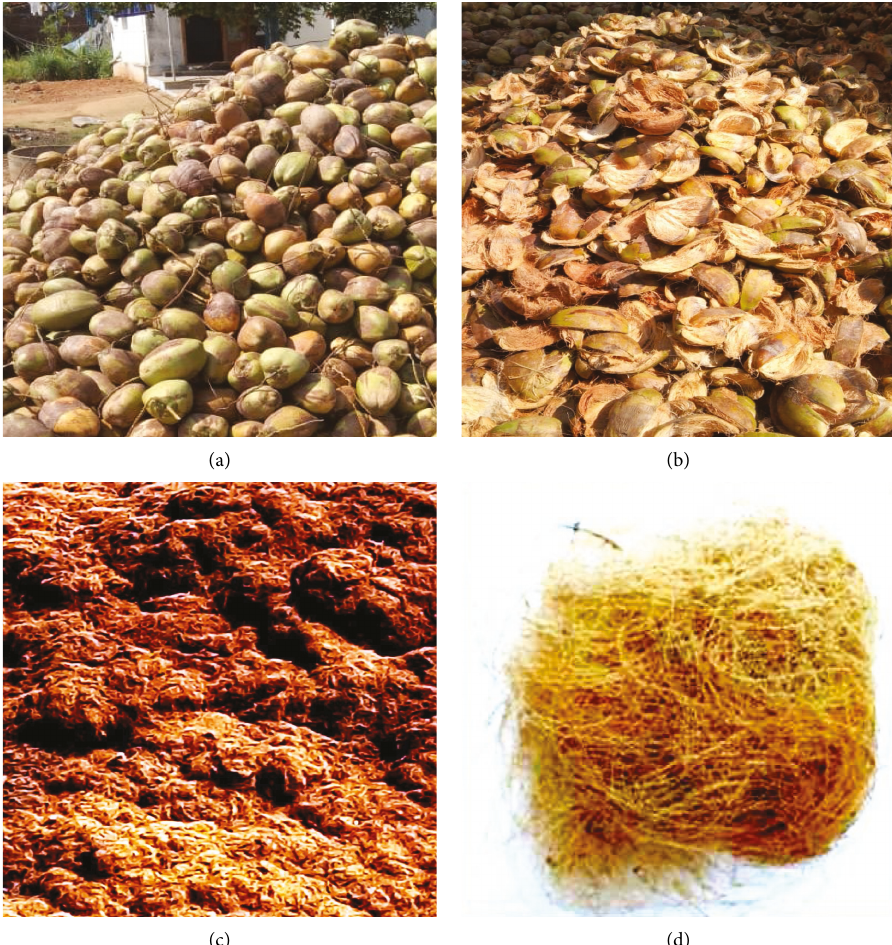
Figure 2: Schematic images of sample collection. (a) Primary husk. (b) Shells for backing support. (c) Areca husk fibre. (d) Coir